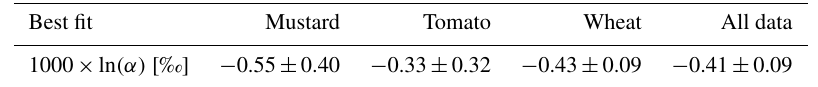
Table 5. 30 Si / 28 Si isotope fractionation factor 1000 × ln (α) numerically approximated by reducing root-mean-square deviation (“best fit”) using Eq. (6) and uncertainties (1s) from the Monte Carlo method with n = 500 seeded individual